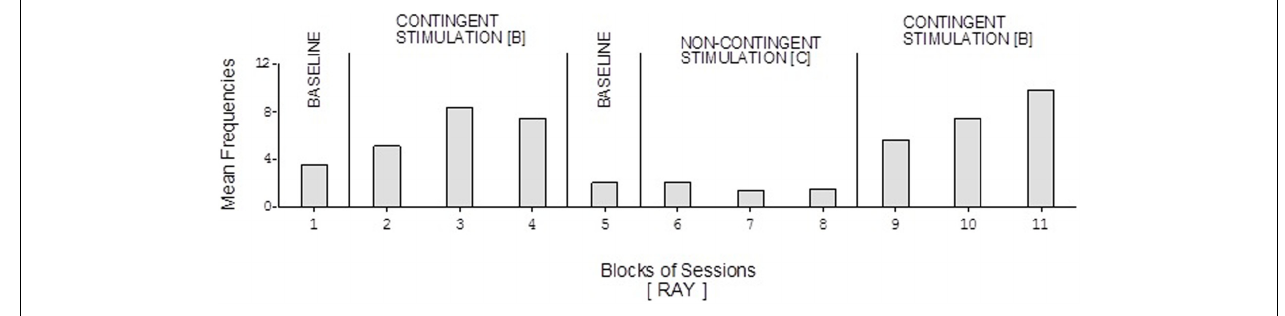
FIGURE 7 | Ray’s data plotted as in Figure